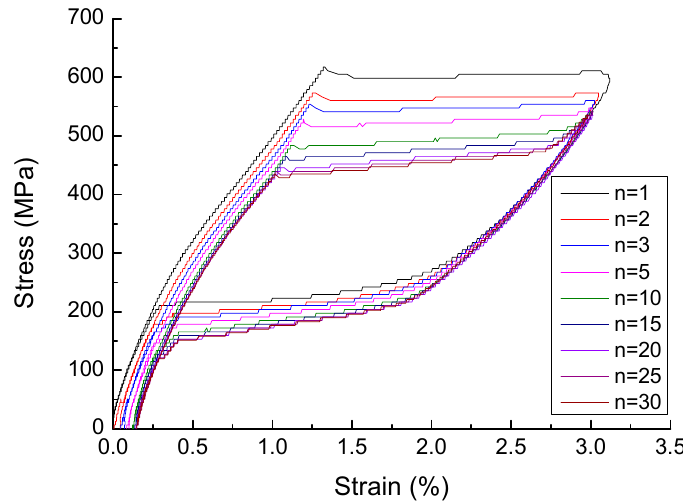
Figure 2. Stress-strain curve of austenite SMA wire with different cycles. Table 1. Mechanical properties of SMA wires with different cycles.